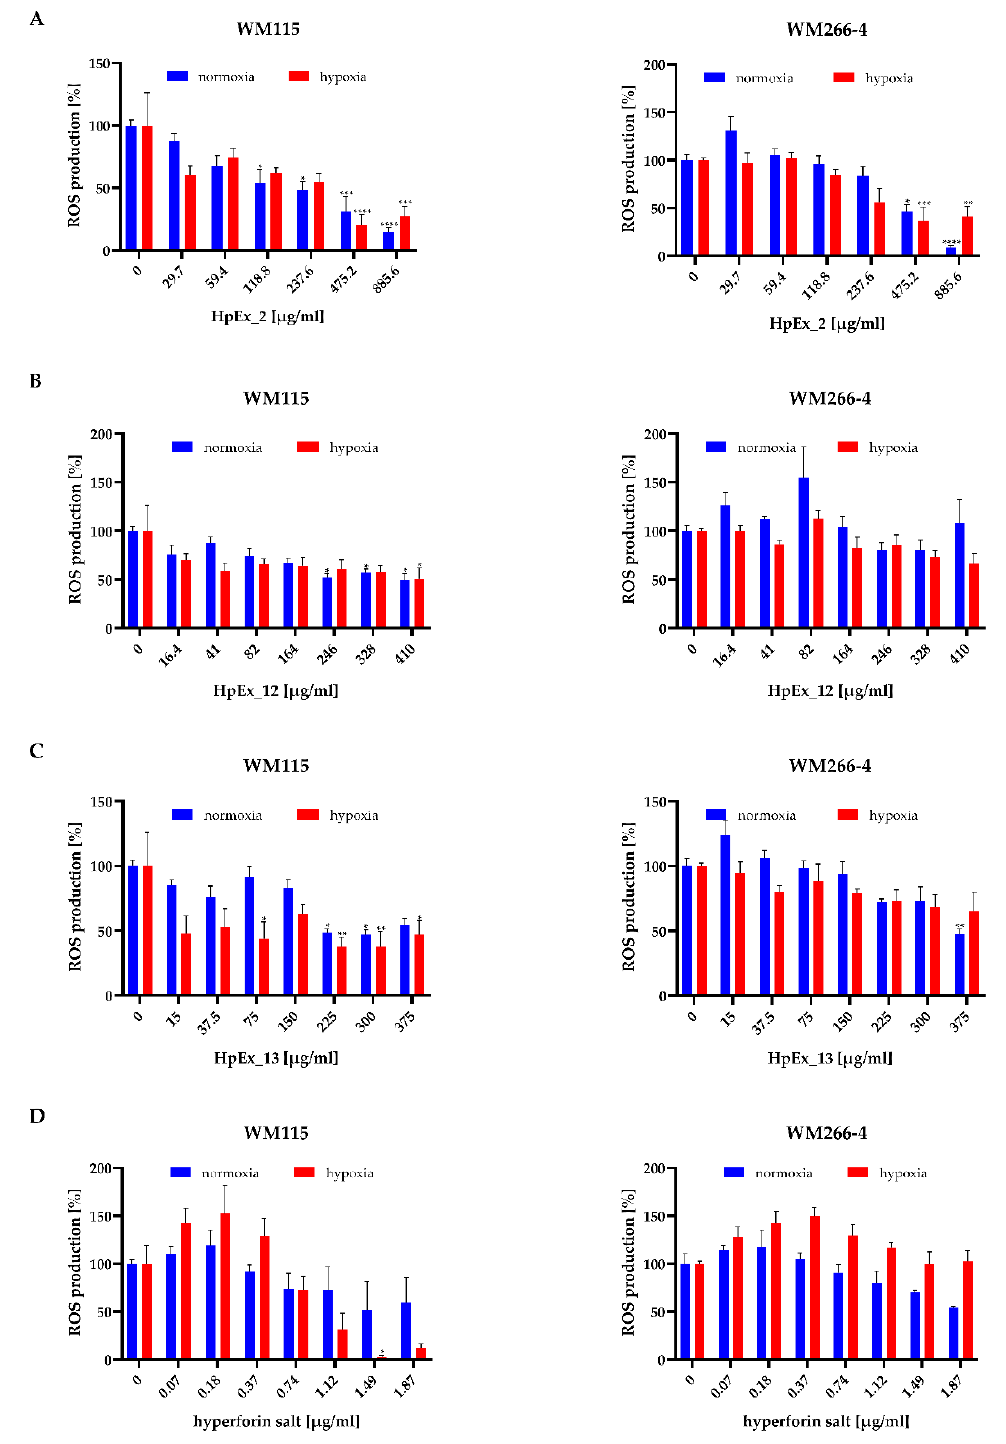
Figure 4. Effect of Hypericum perforatum extracts HpEx2 ( A ), HpEx12 ( B ), Hpx13 ( C ) and hyperforin salt ( D ) on ROS production by WM115 and WM266-4 melanoma cells cultured under normoxia (blue bars) and hypoxia (red bars), determined by the NBT assay. Results are expressed as mean values ± SD. The statistical significance of the data was assessed using a two-way ANOVA, followed by a Tukey’s test for a fair significant difference over multiple ranges. Significance levels between treated cells relative to untreated cells are indicated with asterisks as follows: * p ≤ 0.05; ** p ≤ 0.01; *** p ≤ 0.001; **** p ≤ 0.0001.